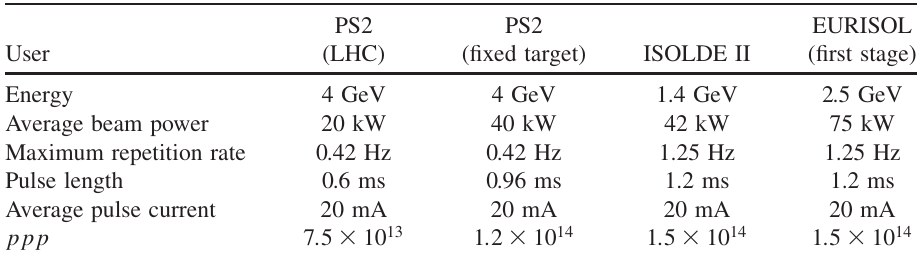
TABLE II. LP-SPL beam parameters for LHC, PS2 fixed target, and radioactive ion